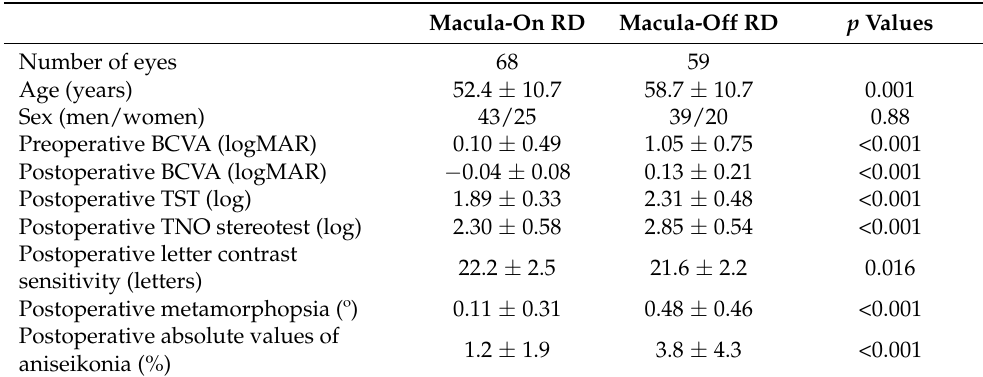
Table 4. Clinical features and visual functions in patients with macula-on and macula-off retinal detachment